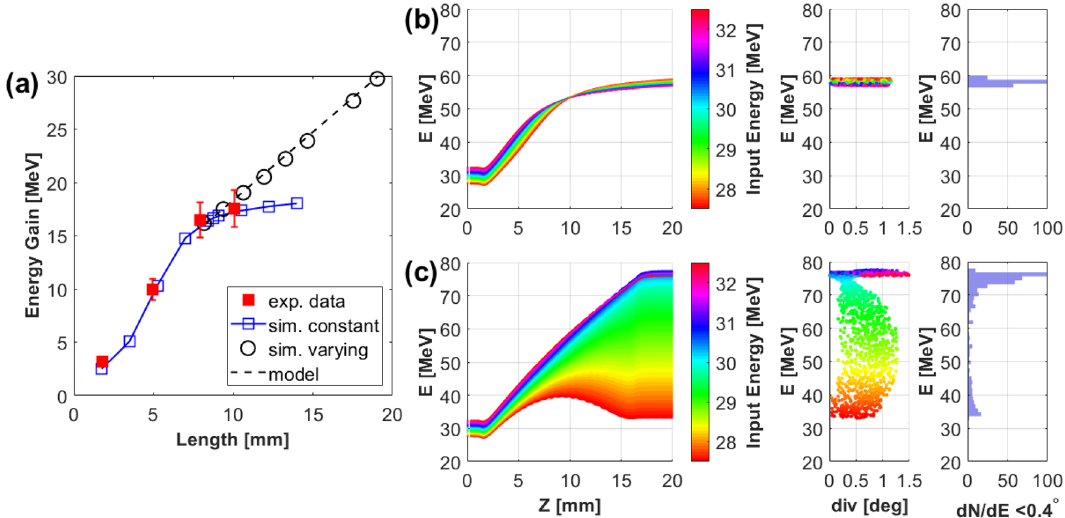
Figure 4. (a) Energy gain as a function of length of the HC target obtained from experiment (red) and simulations (Blue). The HC targets ( 0.7 ± 0.015 mm internal diameter and 0.35 ± 0.015 mm pitch) used in this case were similar to that used for the data shown in Fig. 3, except the length of HC which was varied from 2 to 10 mm. The simulations were carried out using the particle tracing code, as in Fig. 2, reconstructing the physical dimensions of the HCs used in the experiment and scanning for the HC length beyond the range studied in the experiment. The black circles show the simulated energy gain from a suitably designed varying pitch HC as calculated from the analytical model discussed in the text. (b) and (c) show dynamics of transiting protons (in a similar fashion as Fig. 2) through a constant and a variable pitched HCs, respectively. The HCs in both cases extend from z =1.5 to 16.5 mm with internal diameter 0.5 mm and initial pitch 0.5 mm. While the HC in (b) maintains a constant pitch over its full length, the pitch in (c) was varied according to Eq. (1), which gives a pitch increase of ∼ 13 µ m per turn. The beam divergence shown in (b,c) were taken at z = 100 mm and the energy spectra were plotted for a half-angle divergence < 0.4 ◦